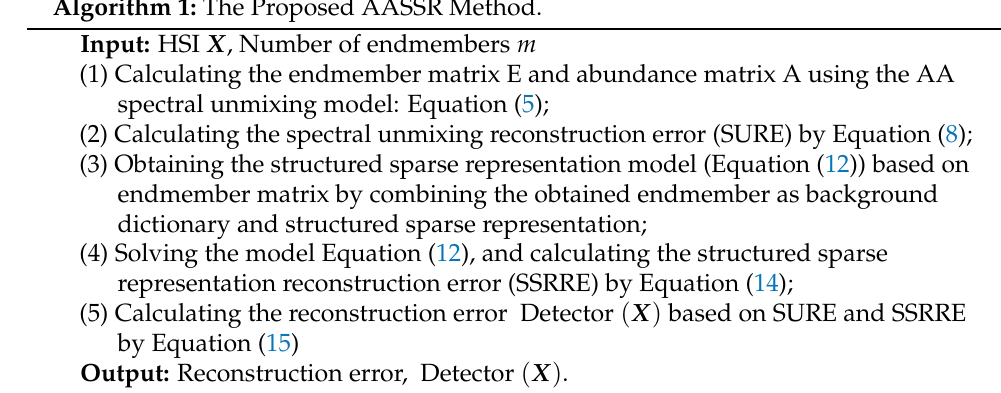
Algorithm 1: The Proposed AASSR